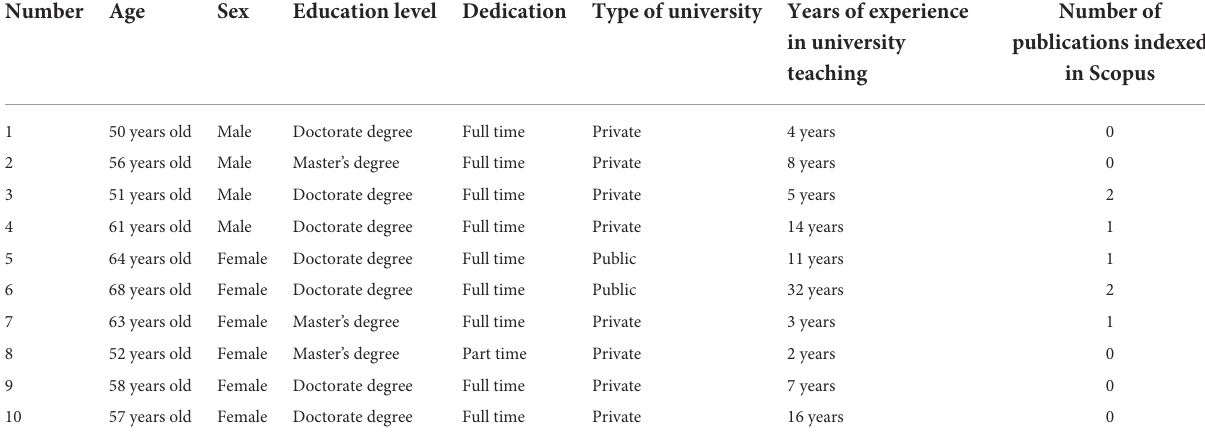
TABLE 2 Characteristics of each teacher participating in the study.